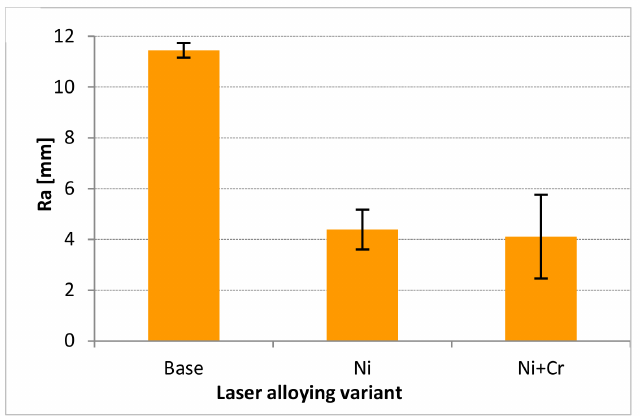
Figure 6. R a parameter of the investigated cultivator coulter for base and after laser implementation of nickel and a combination of nickel and chromium.